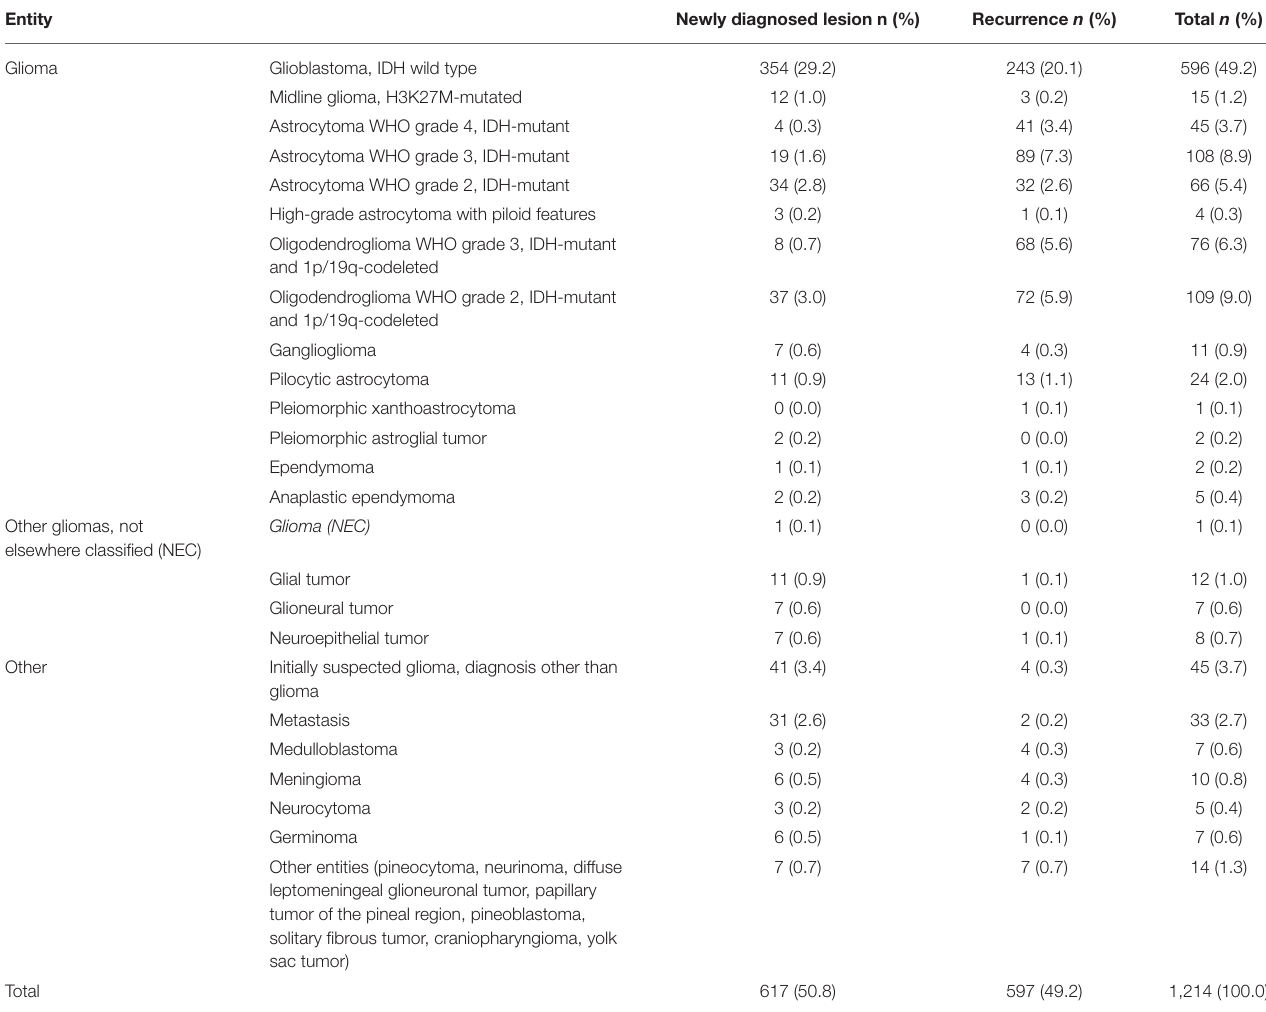
TABLE 2 | Histological